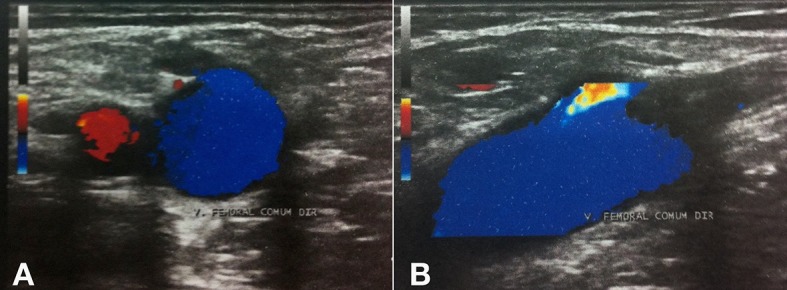
Control Doppler ultrasound after 7 days’ treatment with Rivaroxaban. (A) Color-mode image with transverse transducer; (B) Image in color mode with longitudinal transducer.